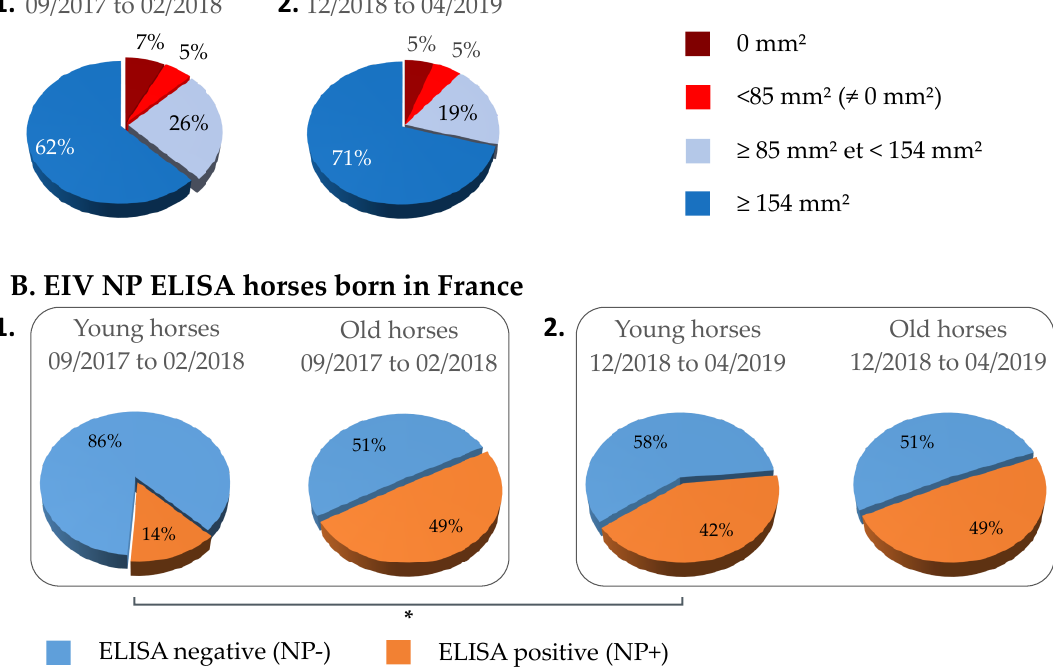
Figure 7. Comparison of overall SRH antibody response ( A ) and EIV NP ELISA ( B ) between two periods of sampling: September 2017 to February 2018 (1) and December 2018 to April 2019 (2). EIV NP ELISA results between serum samples from young ( ≤ 3 years; located in Normandy) and older ( > 3 years; located in the north of France) horses born in France and seropositive by SRH test. (*) p -value ≤ 0.007.